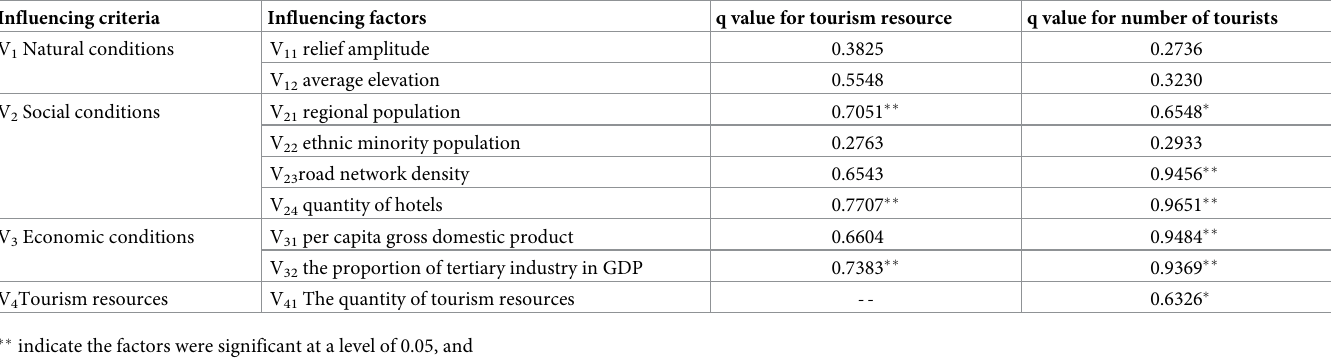
Table 3. Relative influence of the factors on tourism resources and the number of tourists on Hainan Island.